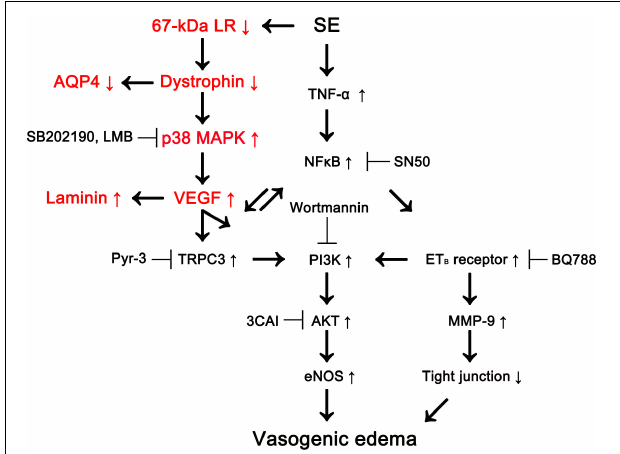
FIGURE 6 | Scheme of role of 67-kDa LR in vasogenic edema formation induced by SE based on the present data and previous reports (Kim et al., 2013, 2016; Kim J.Y. et al., 2015; Min and Kang, 2016). SE reduces 67-kDa LR and dystrophin expressions in astrocytes and endothelial cells, which activates p38 MAPK/VEGF axis. Subsequently, VEGF increases eNOS activity via transient receptor potential canonical channel-3 (TRPC3)/PI3K/AKT signaling pathway, which evokes vasogenic edema formation, along with ET B receptor activation. Down-regulation of dystrophin also decreases AQP4 expression leading to exacerbation of vasogenic edema. In addition, VEGF induces laminin over-expression for recovery of damaged brain